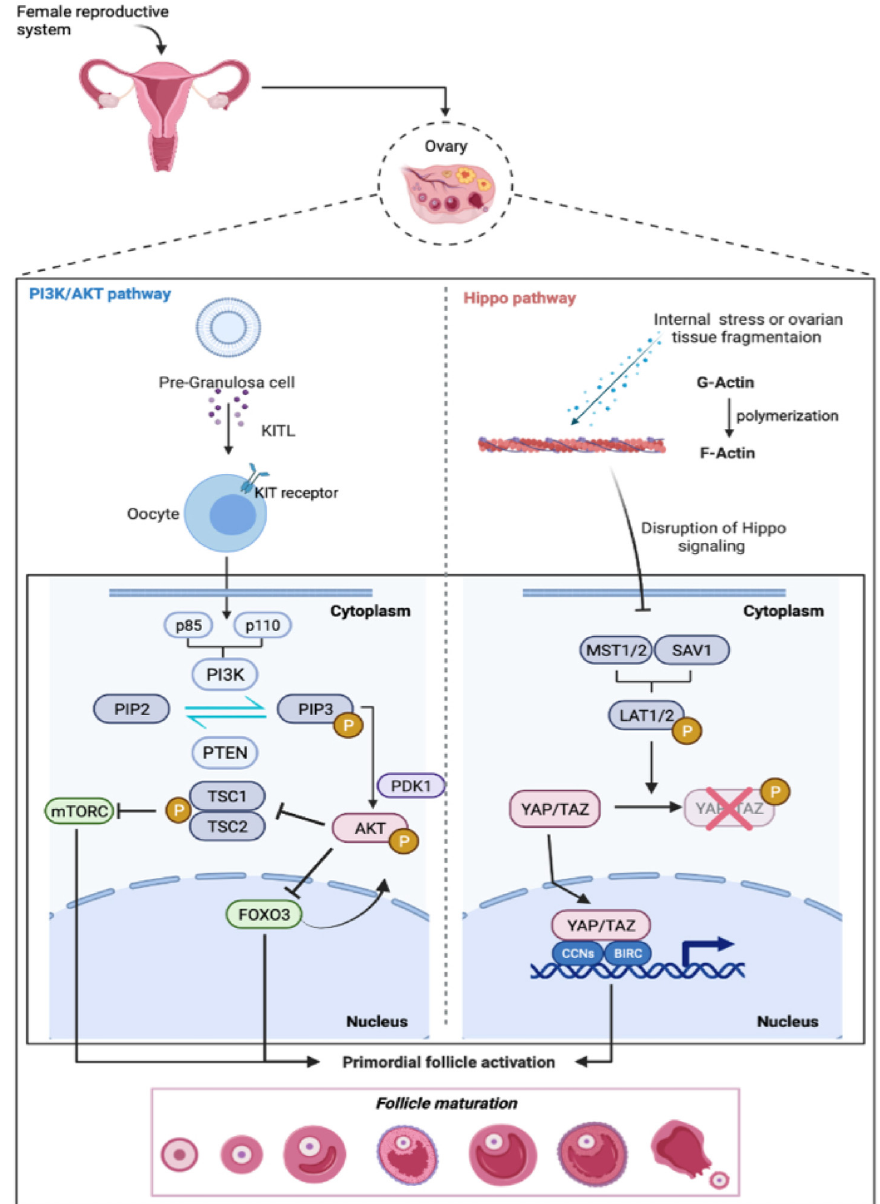
Figure 1. PI3K-PTEN-AKT-FOXO3-mTOR and the Hippo signaling pathways as primary regula- tors of primordial follicle activation . At the top of the figure, the female reproductive system (ovary and follicle enlarged) is shown, as well as a schematic representation of follicle activation steps. In the PI3K/AKT pathway, PI3K is activated by the binding of the KIT ligand (KITL), released by pre-granulosa cells (GCs) to the KIT/tyrosine kinase receptor on the oocyte. PI3K phosphorylates PIP2 into PIP3, promoting PDK1 recruitment to the membrane. In turn, PDK1 activates Akt, which moves to the nucleus and phosphorylates the FOXO3 transcription factor. On the contrary, PTEN dephosphorylates PIP3 to PIP2 while preventing the activation of the follicle. (B) Hippo pathway: Internal stresses or ovarian tissue fragmentations lead to the polymerization of globular actin (G-actin) to filamentous actin (F-Actin), causing disruption to the Hippo signaling pathway, which results in the expression of MTS1/2 and SAV1 complex. The latter is able to phosphorylate LATS1/2 (large tumor suppressor 1 and 2). LATS1/2 prevent the phosphorylation of YAP and TAZ, promoting their translocation into the nucleus. YAP/TAZ stimulate the transcription of downstream growth factors stimulators such as 1 CYR61/CCN1, CTGF/CCN2, and BIRC genes, resulting in primordial follicle activation and development.